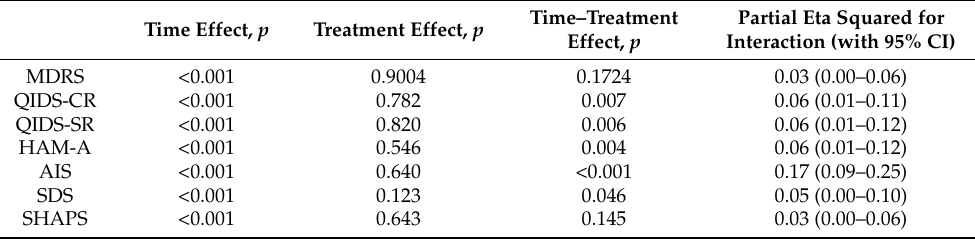
Table 2. Results of mixed-effect model showing the significance levels and effect sizes (par- tial eta squared) for all outcomes. MADRS—Montgomery–Åsberg Depression Rating Scale; HAM-A—Hamilton Anxiety Rating Scale; QIDS-CR—Quick Inventory of Depressive Symptoma- tology, clinician rating; QIDS-SR—Quick Inventory of Depressive Symptomatology, self rating; SHAPS—Snaith-Hamilton Pleasure Scale; AIS—Athens Insomnia Scale; and CGI—Clinical Global Impression